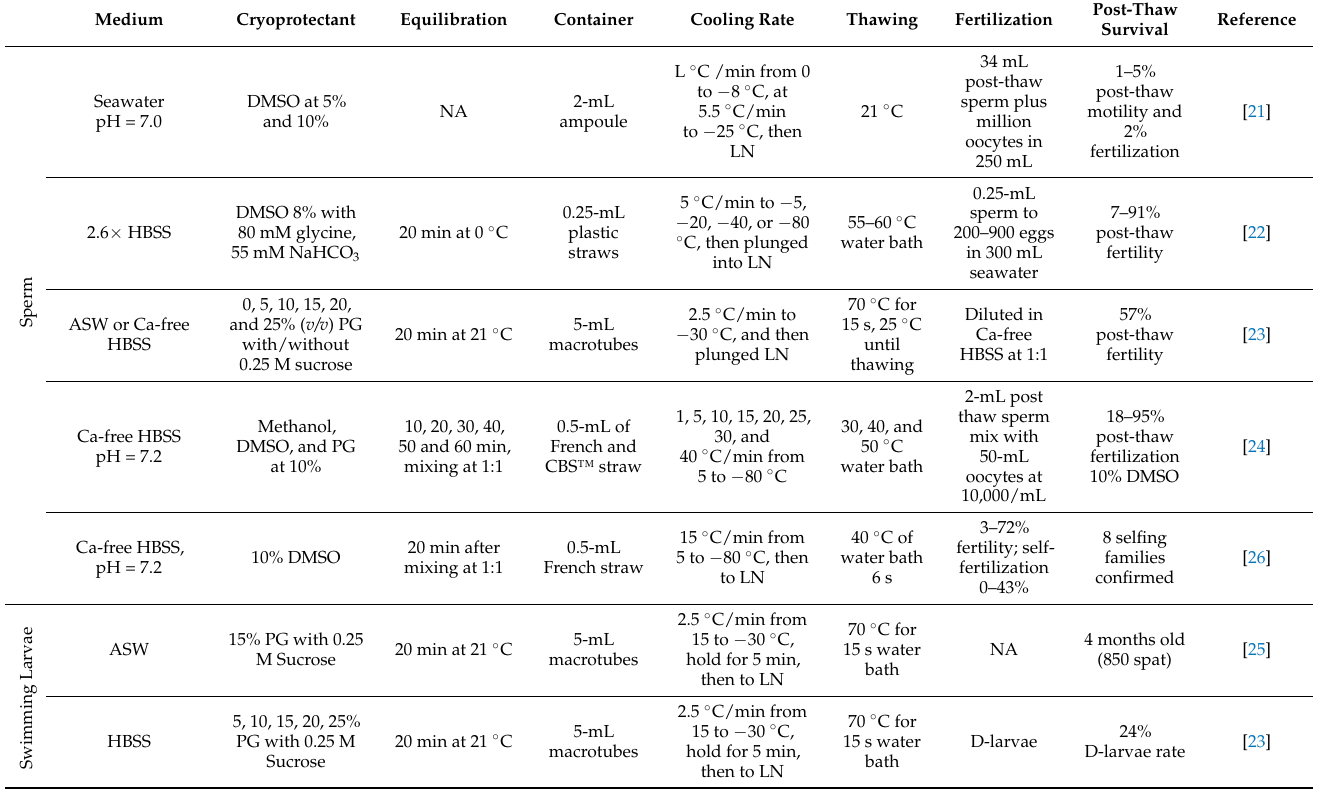
Table 1. Summary of germplasm cryopreservation studies in the eastern oyster Crassostrea virginica. In the current study, the protocol by Yang et al. [24] was used for sperm cryopreservation for establishing the sperm repository. Abbreviations: DMSO: dimethyl sulfoxide; NA: not available; LN: liquid nitrogen; PG: propylene glycol; ASW: artificial sea water. HBSS: Hanks’ balanced salt